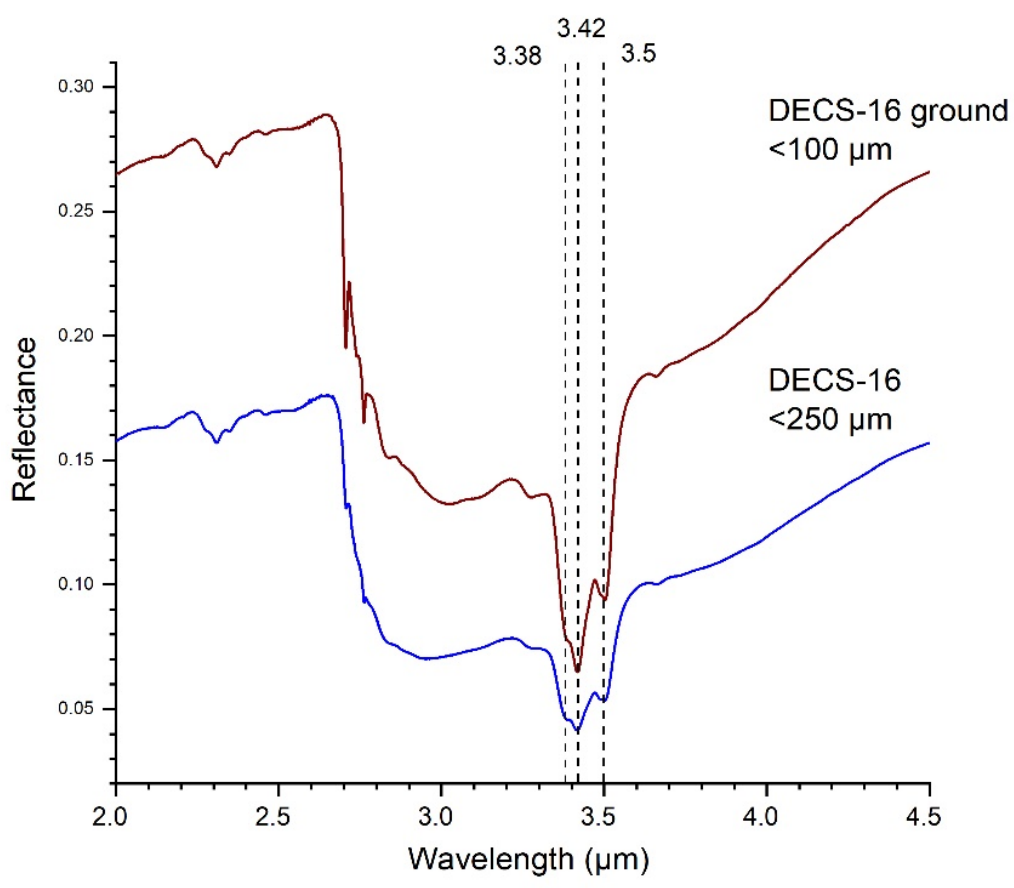
Figure 8. Reflectance spectra of DECS-16 before and after grinding, revealing an increase in absolute reflectance with smaller grain size.